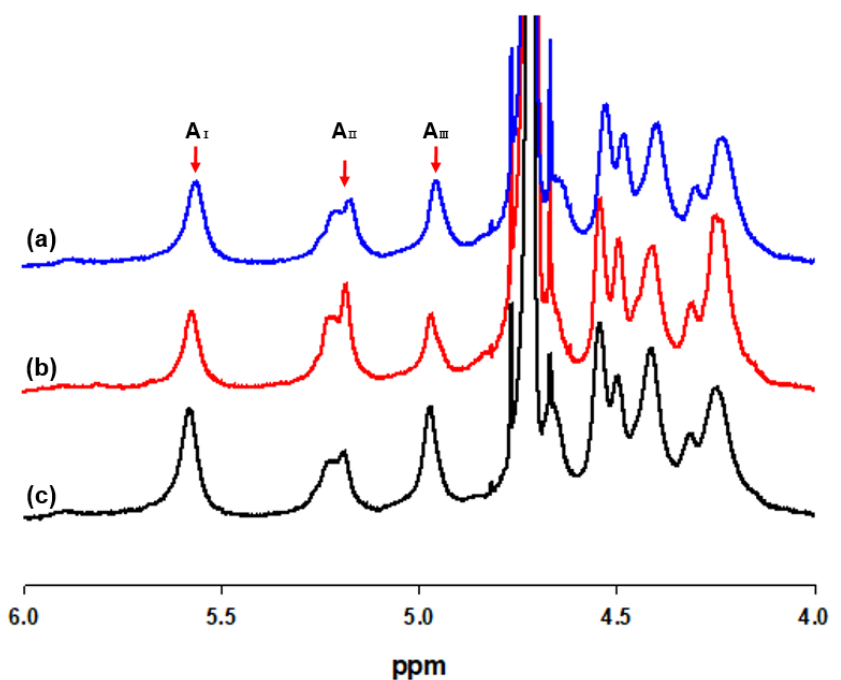
Figure 1. 1 H NMR spectra of sodium alginates extracted from (a) Sargassum fulvellum , (b) S. fusiforme, and (c) S. horneri (A I : Area of guluronic acid anomeric proton peak I; A II : Area of mannuronic acid anomeric proton and the C-5 of alternating blocks peak II; A III : Area of guluronic acid peak III).